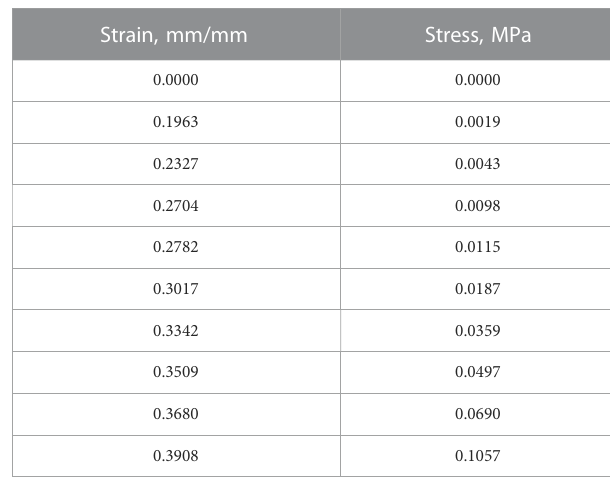
TABLE 2 Piecewise linear mechanical properties describing the non-linear elastic stress-strain behavior of PDL (values were imported into the FEA